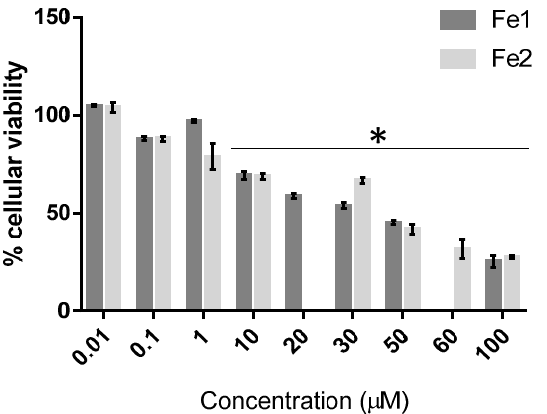
Figure 4. Cell viability (%) after 48 h of exposure of fibroblasts to the Fe1 and Fe2 complexes. Cell viability was determined using the MTS assay. Data expressed as mean ± SEM. * p < 0.05.